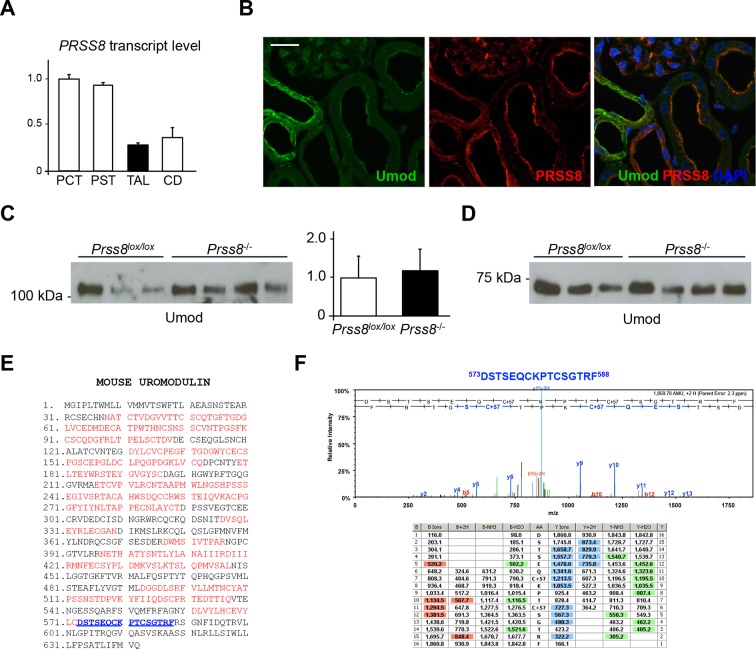
Uromodulin secretion is not affected by lack of prostasin in vivo.(A) Transcript level of Prss8, as assessed by Real-Time qPCR on microdissected nephron segments (normalised to Gapdh). Expression of Prss8 is detected in proximal convoluted tubules (PCT), proximal straight tubules (PST) and, to a lesser extent, in thick ascending limb (TAL) and collecting ducts (CD). Bars indicate average ± s.e.m. of 3 independent experiments (Figure 7—source data 1). (B) Immunofluorescence analysis of mouse kidney sections shows strong signal of endogenous prostasin on the apical plasma membrane of proximal tubules, and weak signal on the apical plasma membrane of TAL epithelial cells where it co-localises with uromodulin. Scale bar, 20 µm. (C) Representative Western blot analysis of urinary uromodulin from control Prss8lox/loxor Prss8-/- mice. Urinary protein loading was normalised to urinary creatinine concentration. Densitometric analysis shows that uromodulin secretion is comparable between Prss8-/- mice and control Prss8lox/loxanimals (average ± s.d., n = 5/group, Figure 7—source data 2) (Student’s t test). (D) Representative Western blot analysis of N-deglycosylated urinary uromodulin secreted by Prss8-/- mice or control animals. An isoform of identical molecular weight, corresponding to the short uromodulin isoform, is detected in urine samples of both genotypes (n = 5/group). (E) Mass spectrometry sequence coverage (55% over the entire protein) of AspN-digested mouse uromodulin (UniProt accession Q91X17) purified from urine of Prss8-/- mice. Matching peptides are shown in red, while the C-terminal peptide is shown in blue. This peptide ends at F588, the same C-terminal residue identified in urinary uromodulin of wild-type mice (Santambrogio et al., 2008) and control Prss8lox/loxanimals (data not shown). (F) Representative MS/MS spectrum confirming the sequence of urinary uromodulin C-terminal peptide (573DSTSEQCKPTCSGTRF588) in Prss8-/- mice and table of fragmented ions.